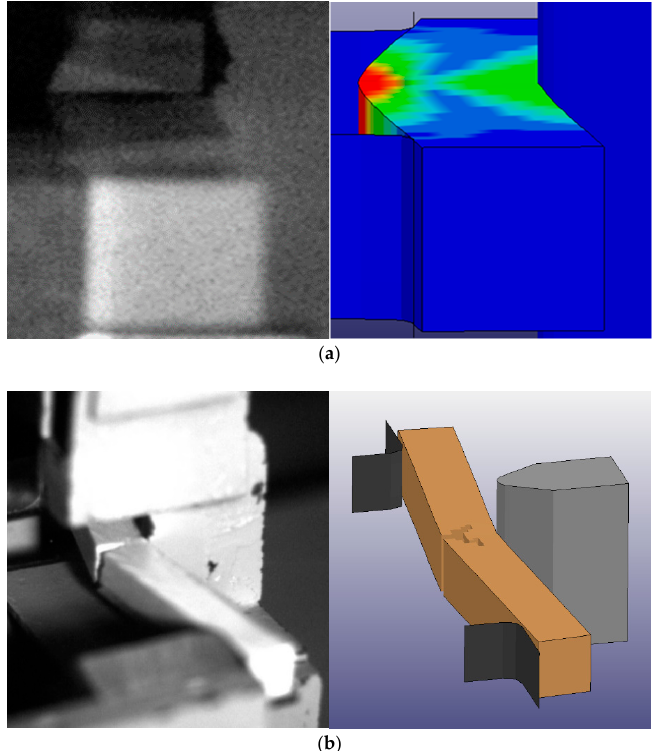
Figure 10. Charpy Impact of maple sample: ( a ) High-speed video image and ( b ) Finite element model showing maximum strain contours ( top ) and crack propagation ( bottom ).